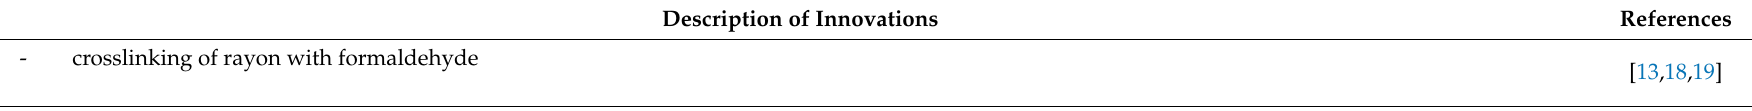
Table 1. A brief history of the development of additives applied in the technology of textile